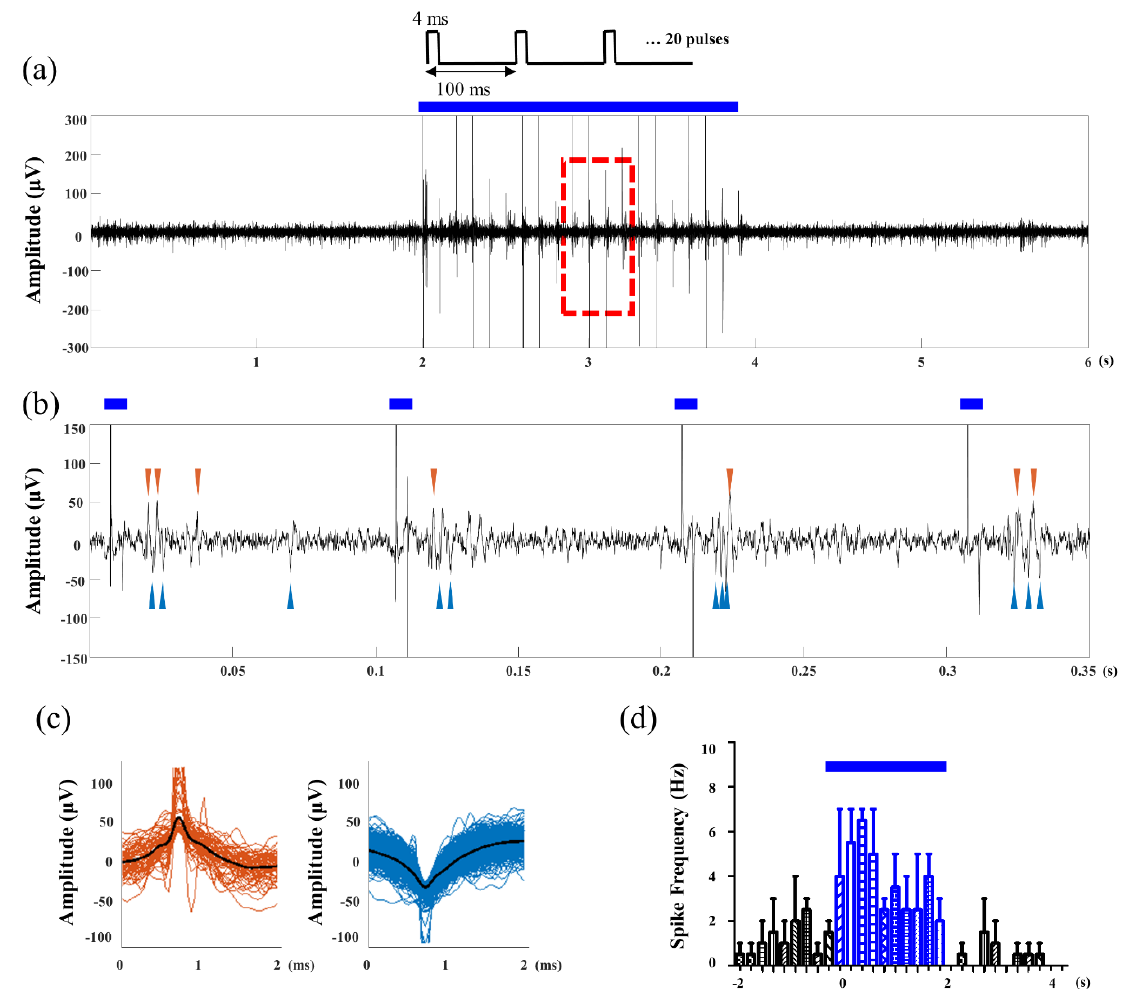
Figure 7. Electrophysiological recording results: ( a ) raw data of the neural recording; ( b ) zoomed waveform showing stimulation artifacts and evoked spikes; ( c ) the sorted spike waveform of two different neurons; ( d ) spike histogram. Throughout the figures, blue bars indicate the time window of the optical stimulation.